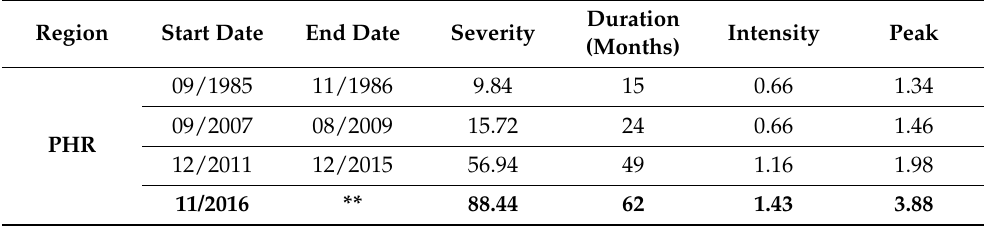
Figure 3. ( a ) Monthly (mm) and ( b ) annual climatology for the PHR, considering the period from 1979 to 2021. The bold black line on the map indicates the PHR data: CPC. Table 4. Drought hydrological events identified via SPI-12 in the PHR, with their respective parame- ters defined in Section 2.3. The longest drought episode is highlighted in